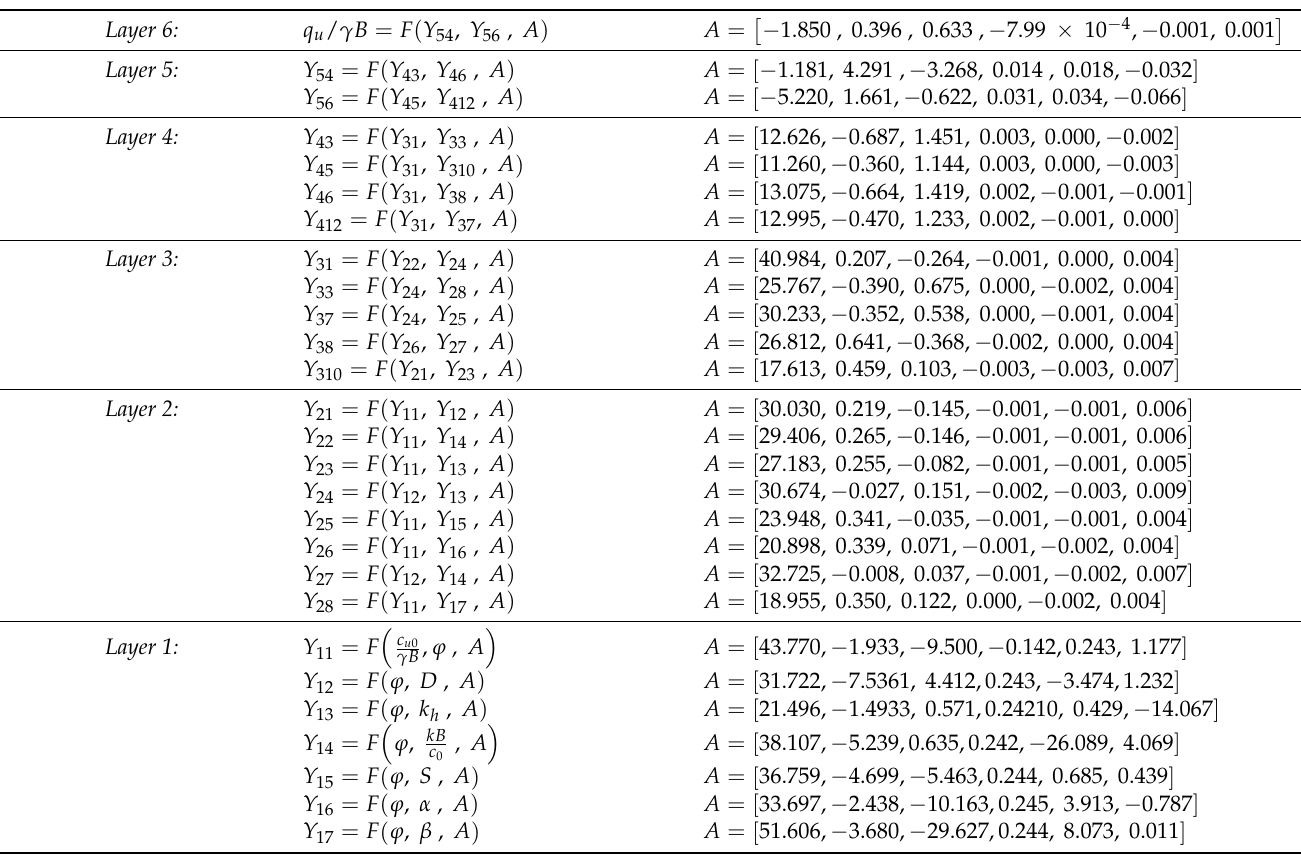
Figure A1. Architecture of the adopted GMDH model. Table A3. Equations derived from GMDH.